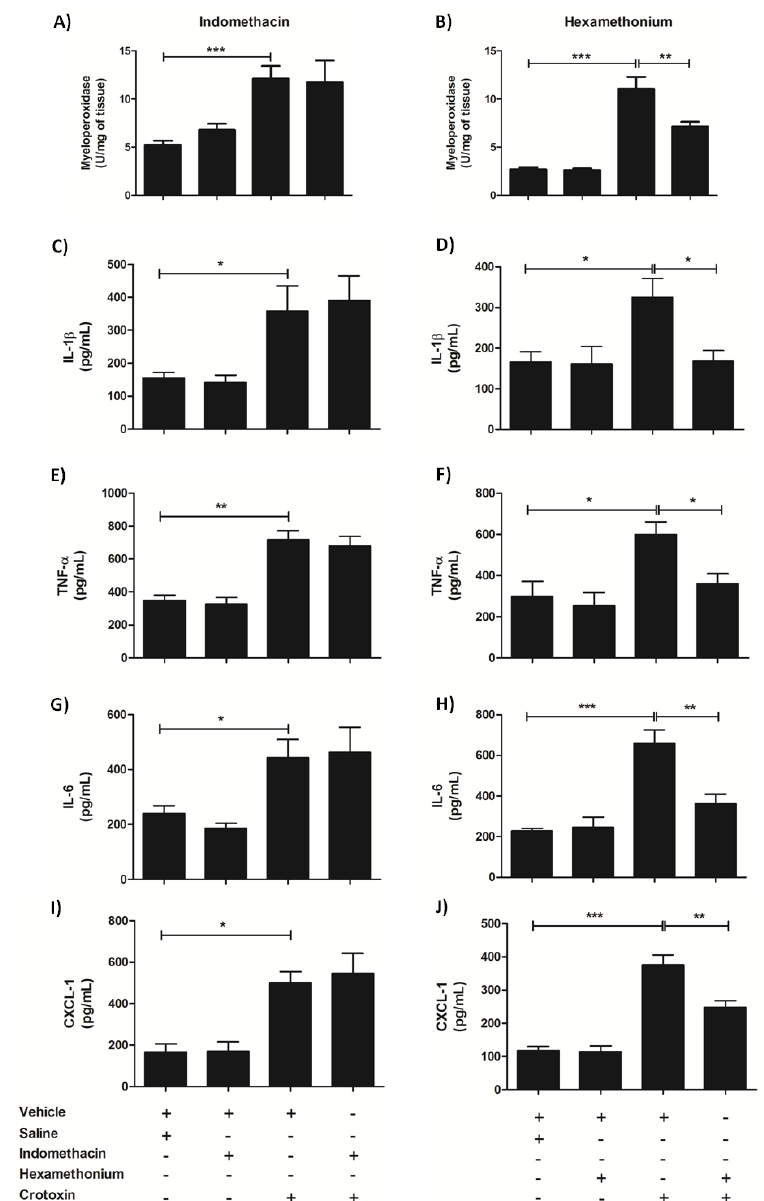
Figure 8. E ff ect of indomethacin and hexamethonium on ctx-induced late phase lung alterations. Animals were treated with indomethacin (3 mg / Kg i.p.) or hexamethonium (10 mg / Kg i.v.), or their respective vehicles, before CTX (300 µ g / Kg s.c.) administration. After 12 h, lungs were collected for quantification of ( A , B ) Myeloperoxidase activity, ( C , D ) Interleukin 1 β (IL-1 β ), ( E , F ) Tumor necrosis factor α (TNF- α ), ( G , H ) Interleukin 6 (IL-6), and ( I , J ) Keratinocyte-derived chemokine (CXCL-1). The results are representative from two independent experiments ( n = 6–7 animals / group). * p < 0.05, ** p < 0.01, and *** p < 0.001—one-way ANOVA followed by the Tukey’s multiple comparison